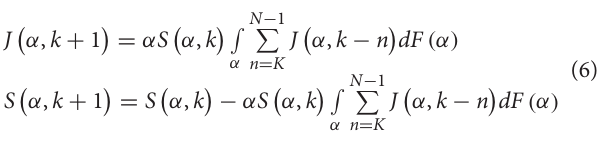
TABLE 1 | Daily increase in the number of infection cases at the epidemic’s initial stage as the function of reproduction number, R 0 , and the duration of sterile/infectious period, t